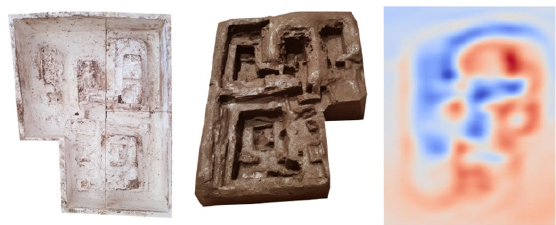
Figure 6 . Printed mold (left); Clay model (center); First results: horizontal section